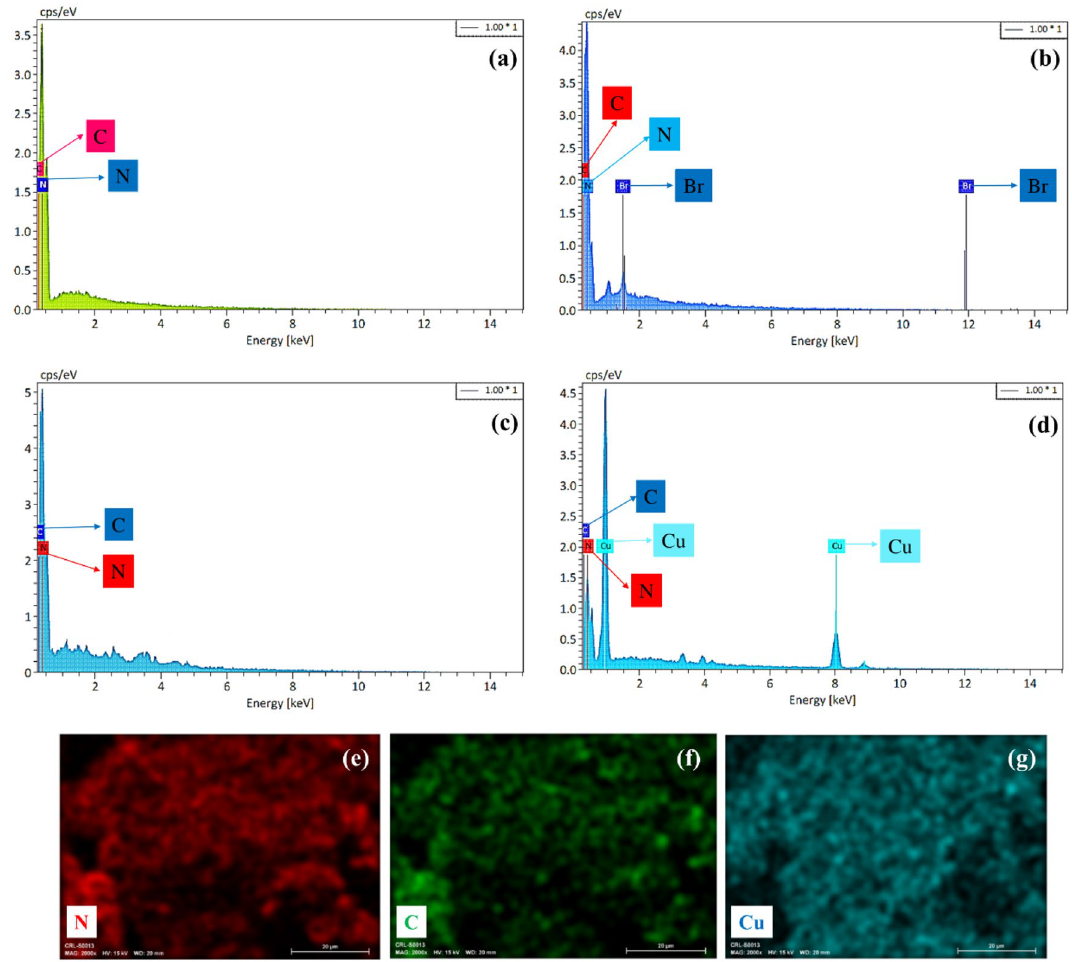
Figure 3. EDS spectrum of ( a ) CN, ( b ) CN–Pr–Br, ( c ) CN–Pr–Met, ( d ) CN–Pr–Met–Cu(II) and ( e–g ) elemental mapping of the CN–Pr–Met–Cu(II).